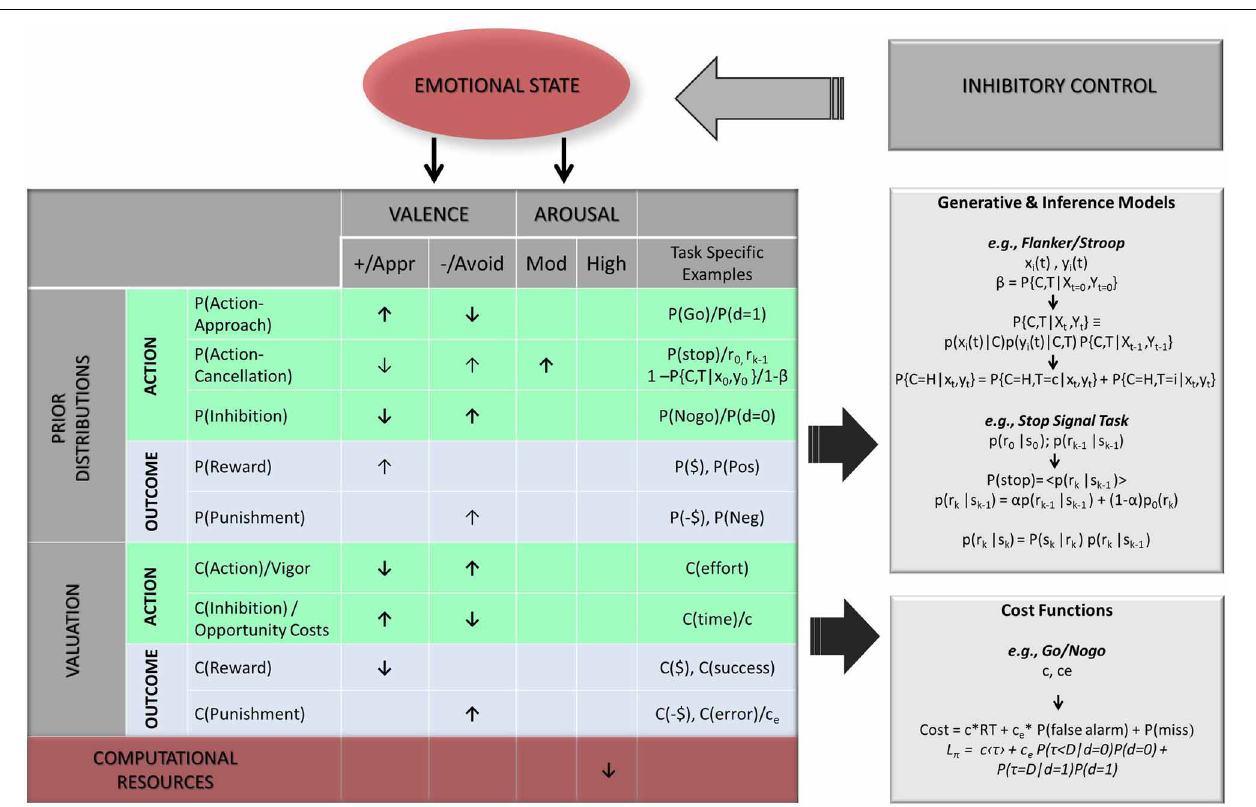
FIGURE 4 | Hypothesized biases of emotional dimensions on Bayesian model parameters. Two categories of parameters are considered: prior probability distributions [means; P (); top panel] and relative costs [ C (); bottom panel], each being further evaluated in terms of primary action related expectancies (green areas) and task contingent outcomes (light blue areas). Legend: arrows indicate hypothesized direction of bias, with bolded arrows indicating stronger or more likely biases ( ↑ , increase/higher value; ↓ , decrease/lower value); Valence Dimension: + /Appr, positive/approach; − /Avoid, negative/avoidance; Arousal: Mod., moderate; Pos, positive/rewarding outcome/stimulus; Neg, negative/punishing outcome/stimulus; $, monetary reward; -$, monetary penalty; α , mixing factor; P ( C , T | X 0 , Y 0 ) / β , probability of trial being congruent at trial onset t = 0 (e.g., in Stroop or Flanker task); x ( t ) = sensory input for central